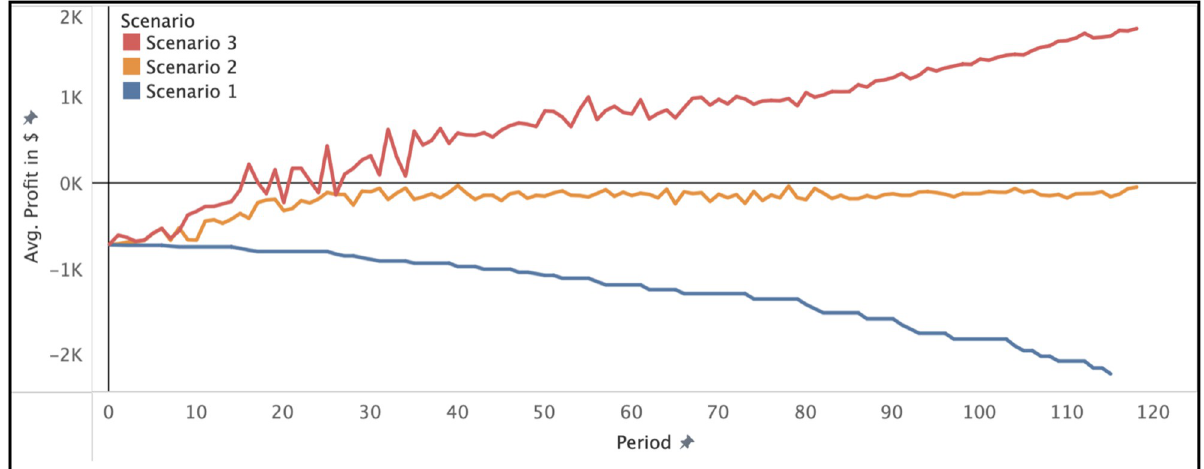
Fig 3. Profit over time for each